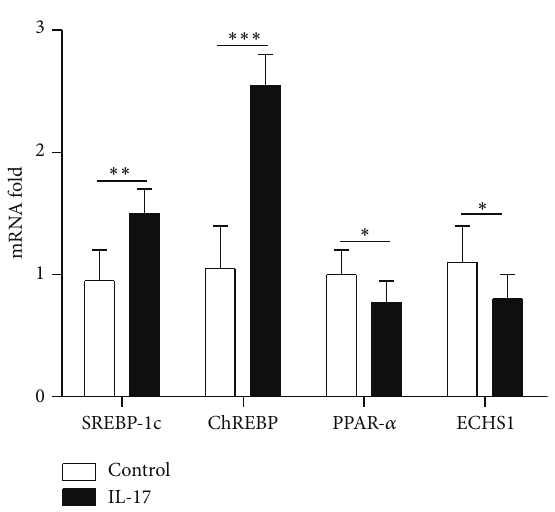
Figure 7: The effect of an intravenous dose of 1 𝜇 g of IL-17 on the transcript levels for the four selected proteins in vivo. The expression levels of SREBP-1c, ChREBP, ECHS1, and PPAR- 𝛼 mRNA were determined in livers collected 16 hours after being intravenously injected with IL-17. Gene expression levels in mice from the control group were set at 1. The data indicate Mean ± SEM of three separate experiments. ∗ 𝑃 < 0.05 ; ∗∗ 𝑃 < 0.01 ; ∗∗∗ 𝑃 < 0.001